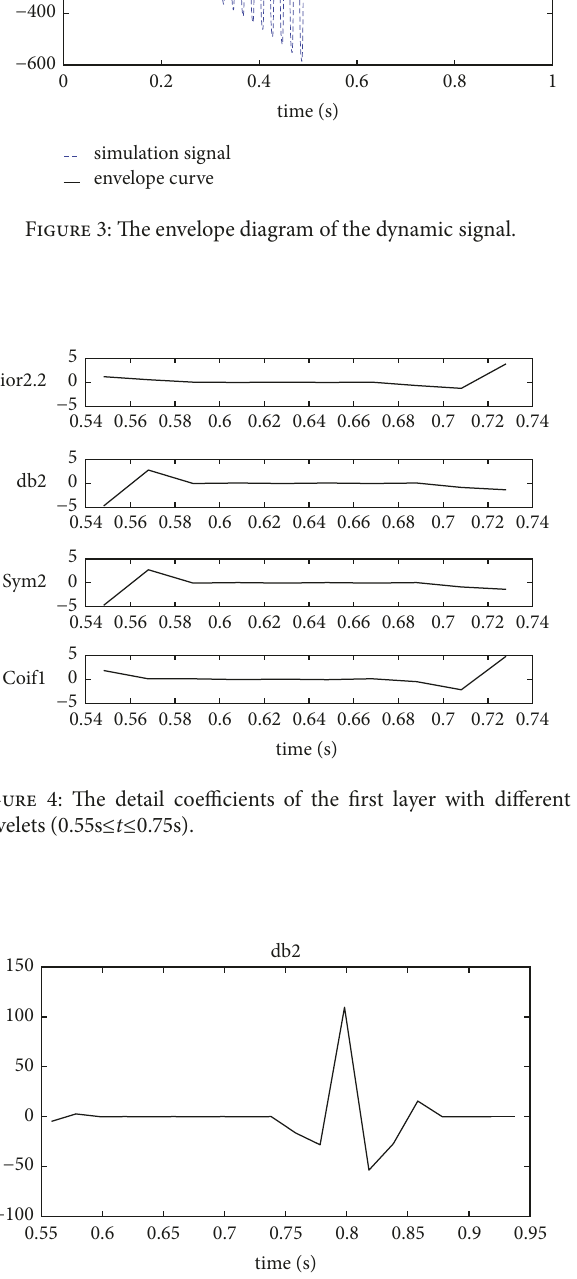
Figure 5: The detail coefficients of the first layer when applying db2 (0.55 s ≤ t ≤ 0.95 s ).